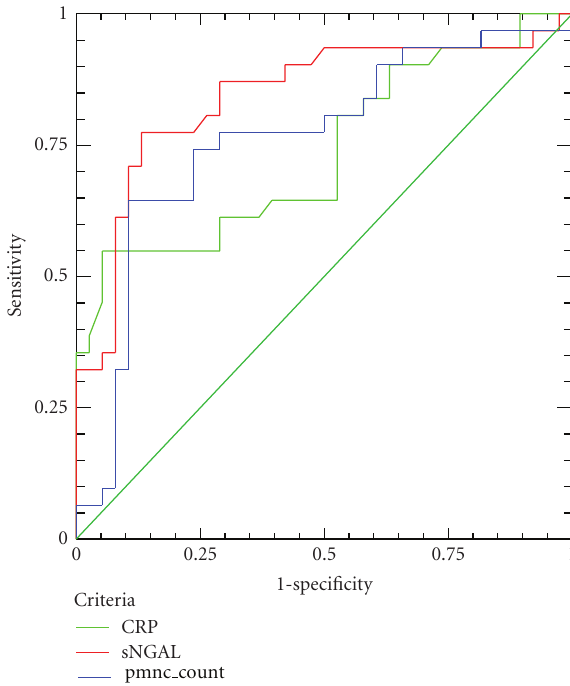
Figure 5: ROC curve analysis for CRP (green line), serum-NGAL (red line), and PMN count (blue line) for the discrimination of UA patients from patients with